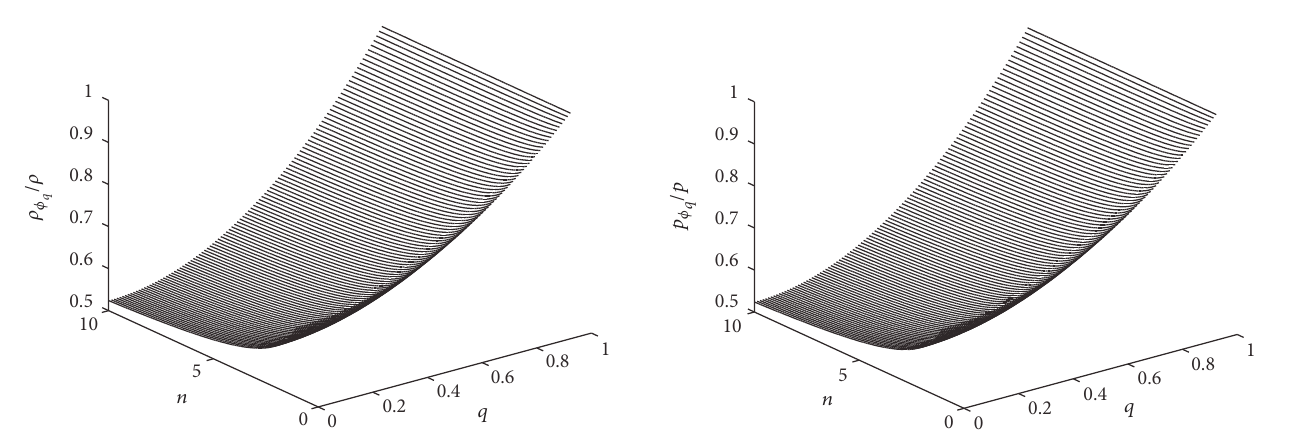
Figure 7: q -deformed pressure for various values of 𝑛 and 𝑞 , in terms of standard